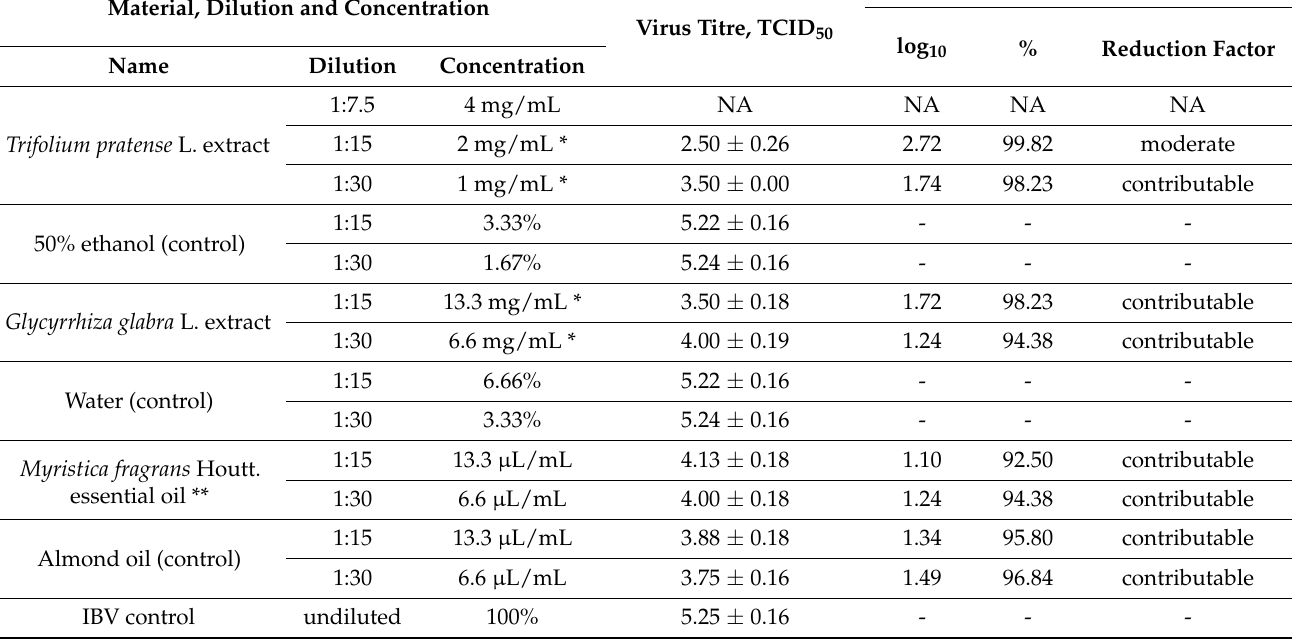
Table 5. Comparison of the virucidal effect of plant extracts on IBV.